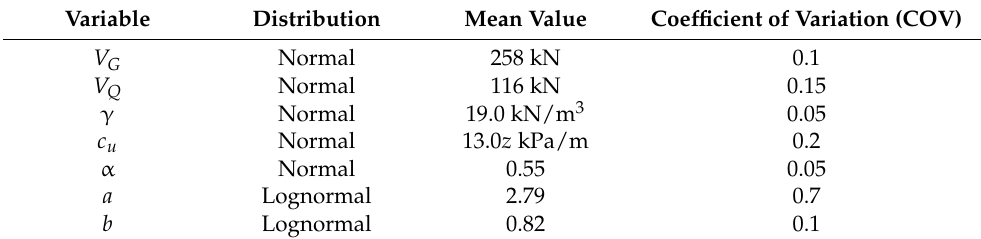
Table 11. The characteristics of random variables.